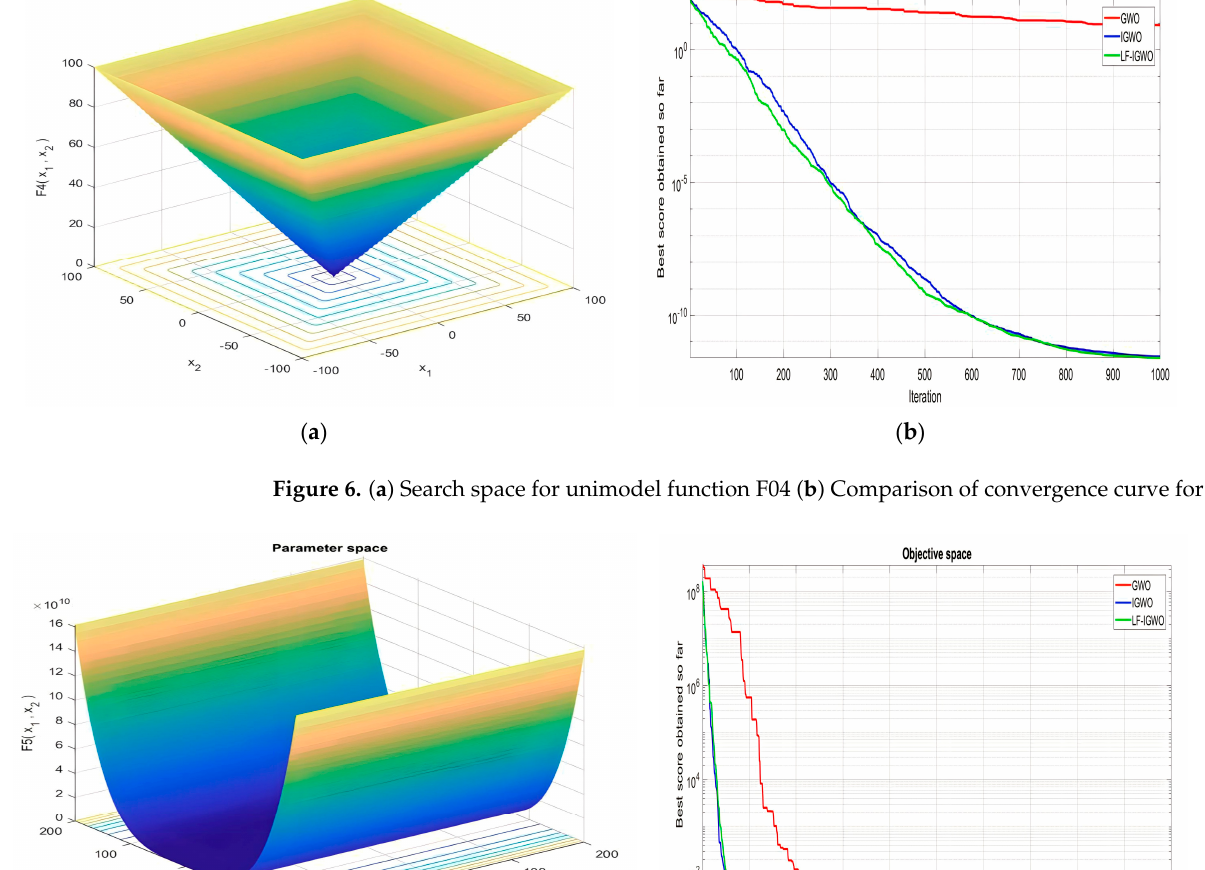
( b ) Figure 9. ( a ) Search space for unimodal function F07 ( b ) Comparison of convergence curve for F07.